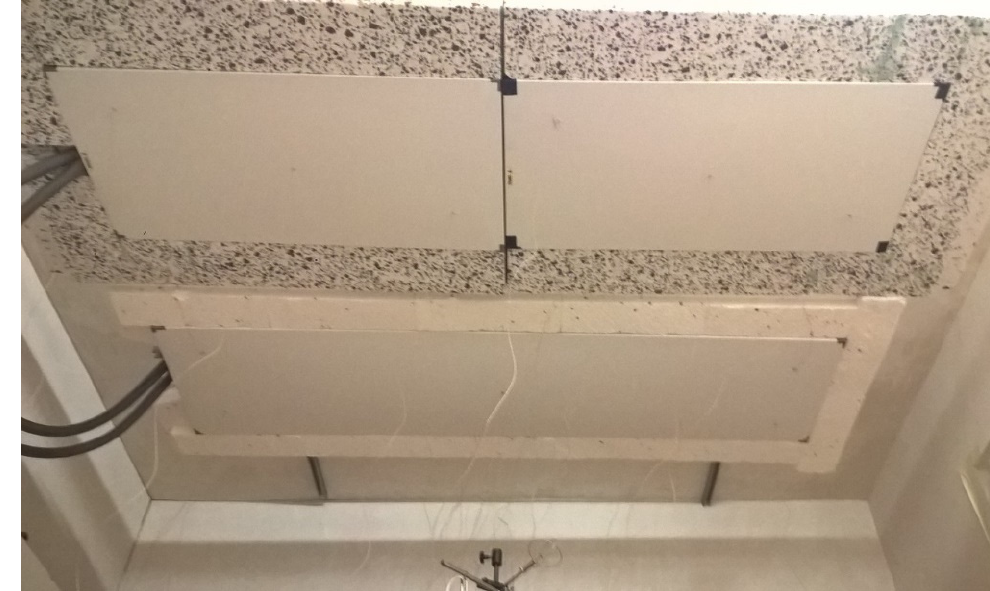
Figure 2. PCM ceiling test stand [42].